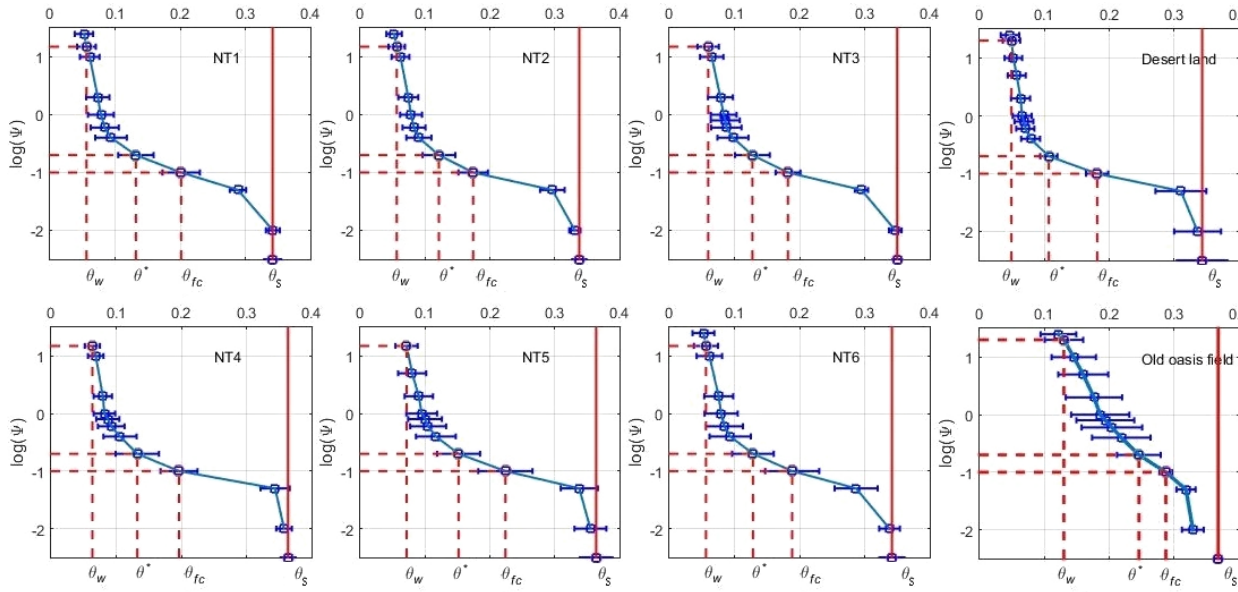
Figure 4. Soil moisture characteristic curve (SMC) of uniform soil profiles of the six experimental plots and two other representative fields. The soil field capacity ( θ fc ), wilting point ( θ w ), and water stress point, i.e., the point of incipient stomatal closure ( θ ∗ ) are empirically related to the corresponding soil matric potentials ( − 0 . 1bar for θ fc , − 0 . 2bar for θ ∗ and − 15bar for θ w ); the blue horizontal line represents the error bar, and the solid red line represents saturated water content ( θ s ), which was obtained via the traditional soil drying method with three repetitions in each layer; for soil water (matric) potential ( (cid:57) ) take the absolute value, for example, − 0 . 01bar is equal to − 2 on the y